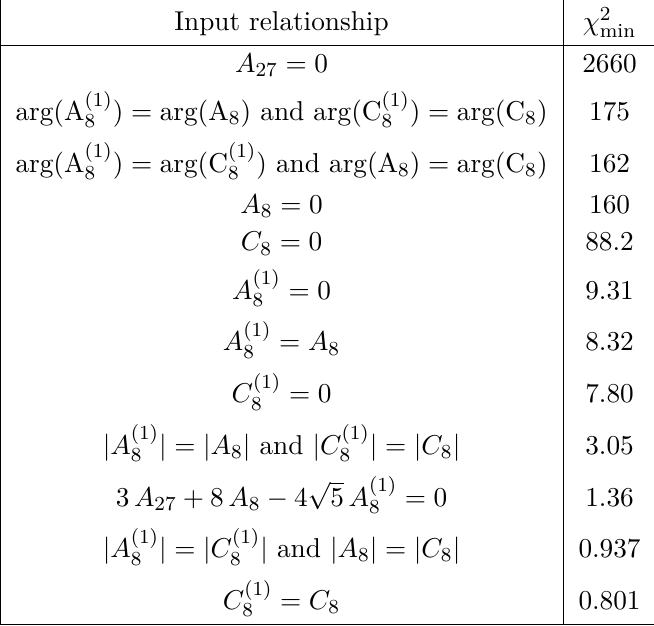
Table 8. Input relationships between SU(3) F matrix elements used to perform χ 2 minimization fits, listed in descending order of minimum χ 2 value obtained in a fit. Each input relationship adds two real-valued constraints. The corresponding fits each have one degree of freedom. arg(X) refers to the phase of the matrix element X